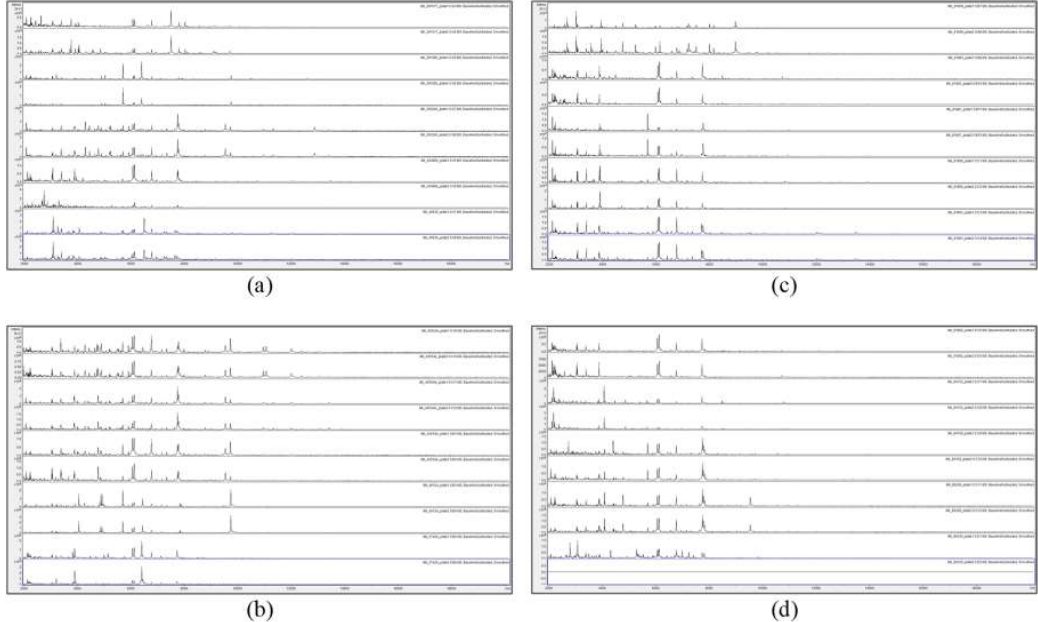
Figure 2. MALDI-TOF MS spectra of acid-soluble fungal proteins from duplicate plates (plate 1 above and plate 2 below), for ( a ) from top to bottom IMI 381617, IMI 381685, IMI 383240, IMI 40496b, and IMI 40636; ( b ) from top to bottom IMI 45554 ii, IMI 45554 iii, IMI, 45554 iv, IMI 49124, and IMI 57426; ( c ) from top to bottom IMI 91859, IMI 91883, IMI 91887, IMI 91890, and IMI 91891; and ( d ) from top to bottom IMI 91892, IMI 94152, IMI 94159, IMI 96228, and IMI